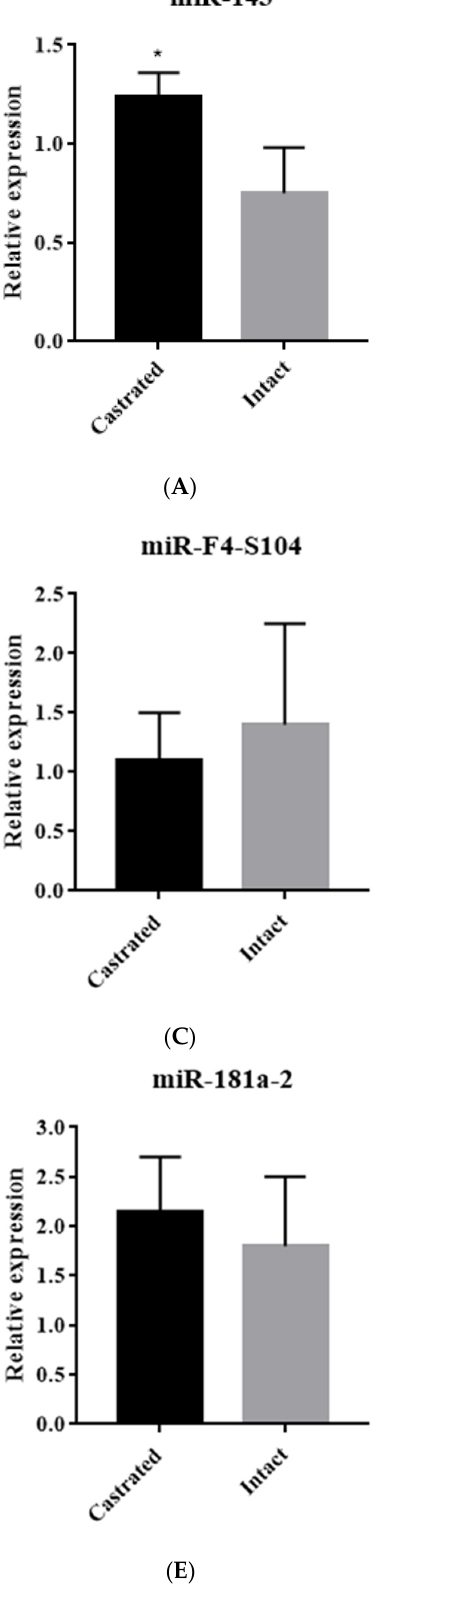
Figure 1. Expression levels of miRNAs in backfat tissues. ( A ) miR-143, ( B ) miR-F4-C12, ( C ) miR-F4-S104, ( D ) miR-F3-C14, ( E ) miR-181a-2. Results are shown as means ± SD of triplicate experiments. * Indicates p < 0.05.